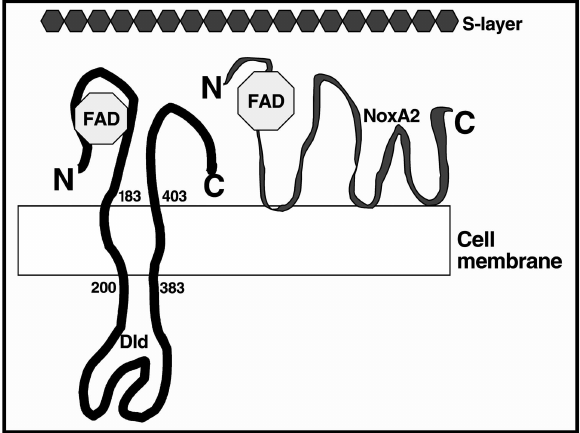
Figure 8. Proposed topology for Dld and NoxA2. Based on the βαβ fingerprint, the predicted binding motif for the ADP portion of FAD is present between residues 68 and 95 in Dld. The regions between resi- dues 183–200 and 383–403 are potential transmembrane regions. There are two candidate binding motifs between the amino acid resi- dues 2–32 and 144–175 for ADP in NoxA2, which binds both FAD and NADH. Short hydrophobic regions between residues 148–153, 230–234, 396–397 of NoxA2 are potential sites of contact with the